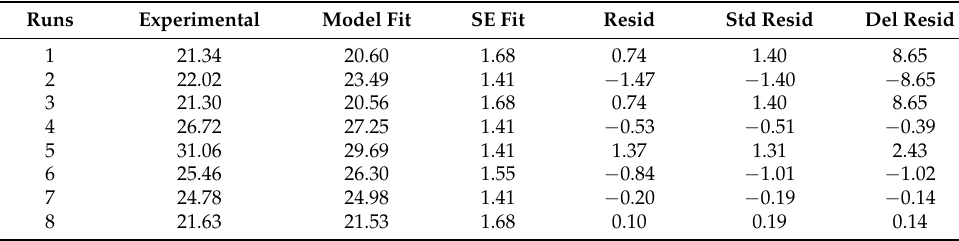
Table 8. Fits and diagnostics for all observations for plateau stress.